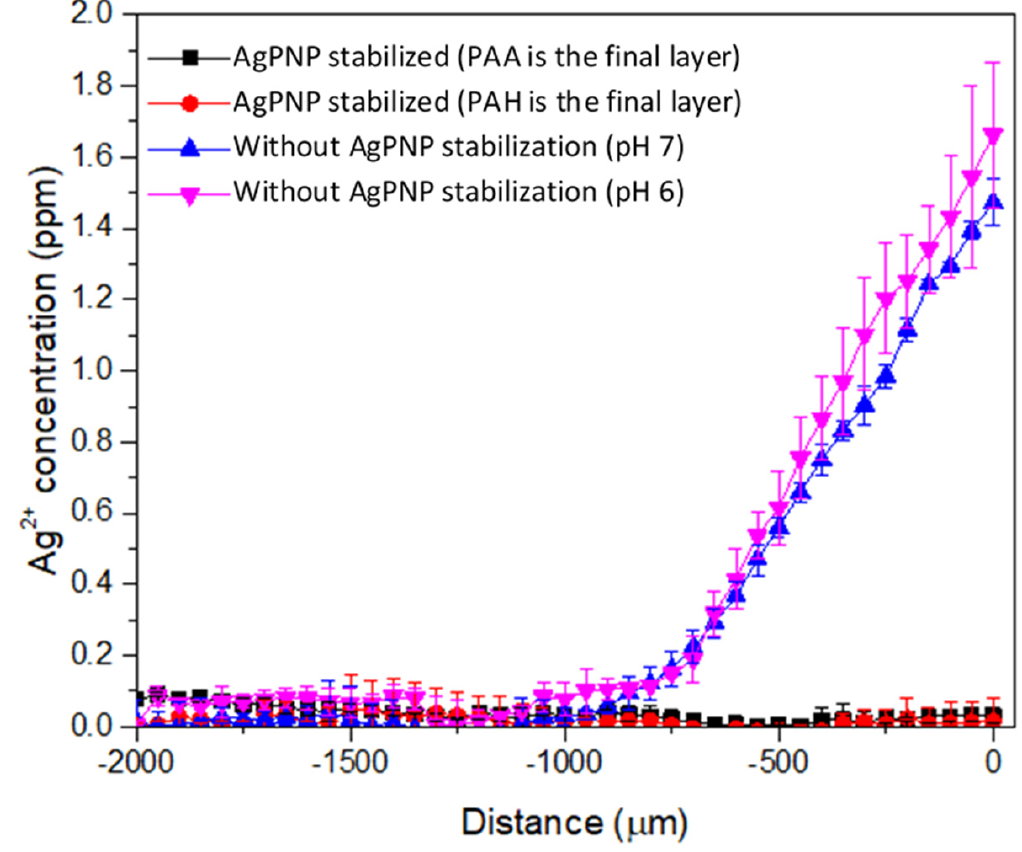
Figure 8. Microprofiling of Ag + on and near functionalized UF membrane surfaces using Ag + micro-ISE.